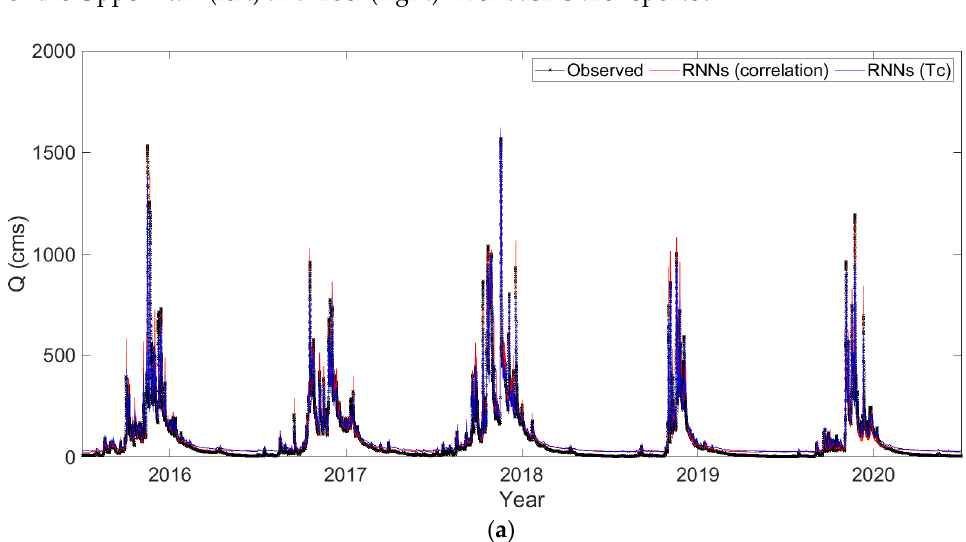
( b ) ( c ) Figure 5. The comparison of observed discharge and 12-h predicted discharge using deep learning model for the Upper Nan River basin ( a ) RNNs ( b ) GRUs and ( c ) LSTMs.